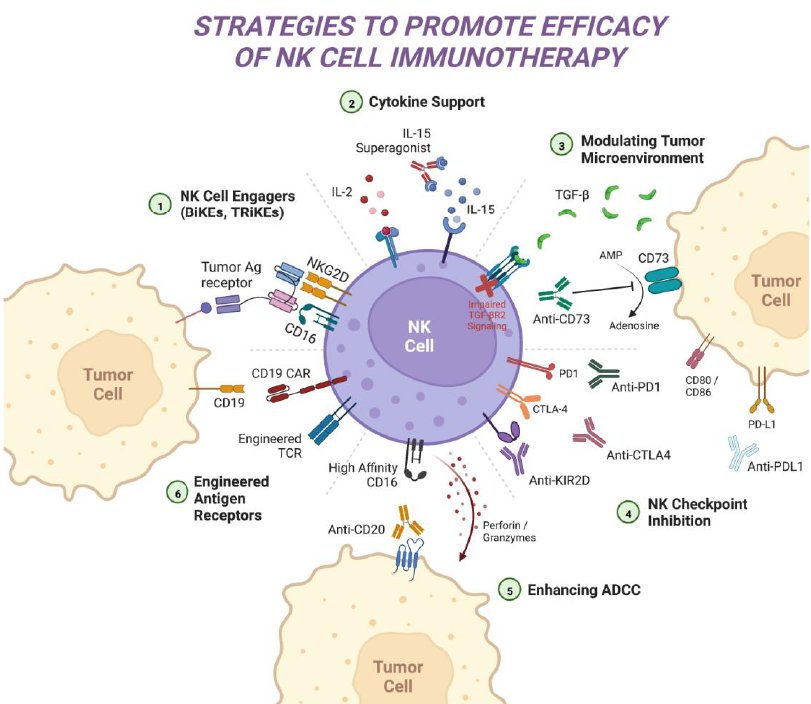
Figure 2. Strategies to promote anti-tumor effector function for NK cell immunotherapy. (1) NK cell engagers include bispecific (BiKEs) and trispecific antibodies (TRiKEs) that bring tumor antigens and supportive cytokines into proximity with NK cell receptors. (2) Supportive cytokine-mediated approaches include the use of IL-2 and IL-15 to promote NK cell expansion and cytotoxicity. (3) Impairing TGF- β signaling and preventing buildup of adenosine in the tumor microenvironment can reduce local suppressive effects on NK cells. (4) Blockade of immune checkpoints (PD-1, PD-L1, CTLA4) and inhibitory NK receptors (KIR2D) may circumvent NK exhaustion and improve anti- tumor function. (5) The addition of monoclonal antibodies and engineering of high affinity CD16 receptors promote the CD16-Fc ligand binding interaction, leading to enhanced ADCC. (6) Engi- neered selective antigen receptors such as CARs and TCRs can redirect NK cells towards specified tumor antigens and increase cytotoxicity. NK: natural killer, BiKE: bispecific killer engagers, TRiKE: trispecific killer engagers, Ag: antigen, NKG2D: natural killer group 2 member D, IL: interleukin, TGF- β: transforming growth factor beta, AMP: adenosine monophosphate, PD-1: programmed cell death protein 1, CTLA-4: cytotoxic T-lymphocyte associated protein 4, KIR2D: killer immunoglobu- lin-like receptor group 2 member D; PD-L1: programmed death-ligand 1, ADCC: antibody-depend- ent cellular cytotoxicity, TCR: T cell receptor, CAR: chimeric antigen receptor. Created with BioRen- der.